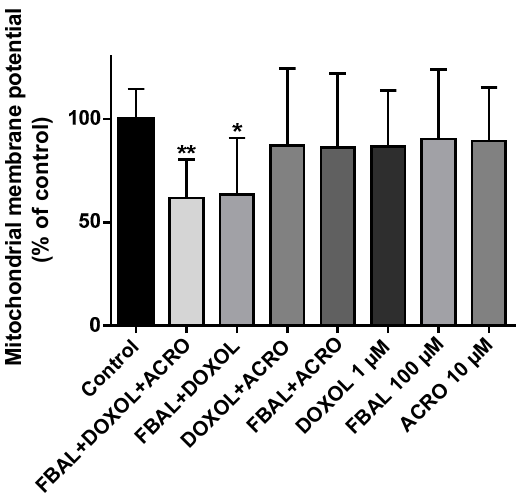
Figure 10. Mitochondrial membrane potential evaluation using the JC-1 dye in differentiated H9c2 cells exposed to metabolites (FBAL 100 µ M, DOXOL 1 µ M, ACRO 10 µ M) or their combination for 48 h. Results are presented as mean ± SD of five independent experiments (total of 14–15 wells). Statistical analyses were performed using the Kruskal–Wallis test, followed by the Dunn´s post hoc test (* p < 0.05, ** p < 0.01 vs. control).